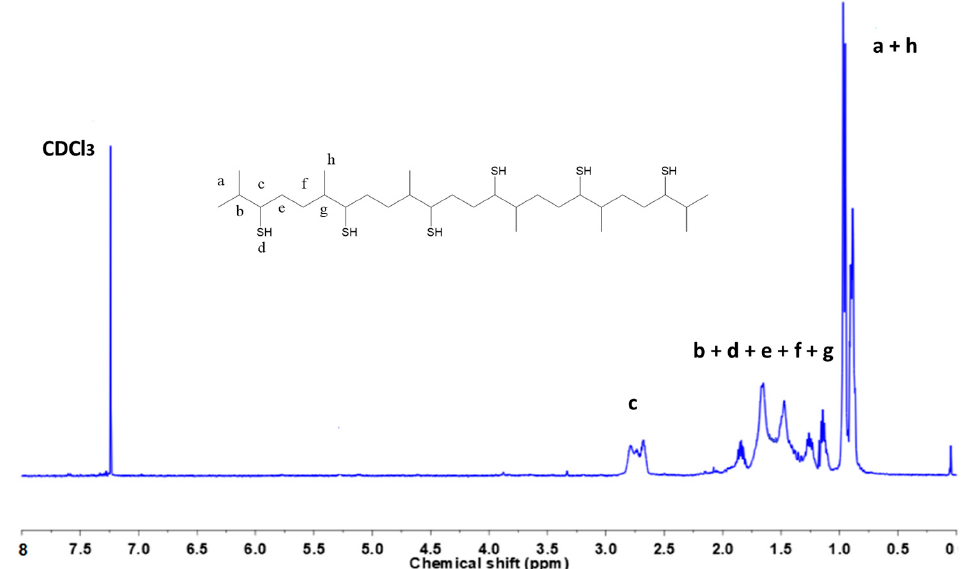
Figure 1. 1 H-NMR spectrum of the hexathiol derived from squalene in CDCl 3 .